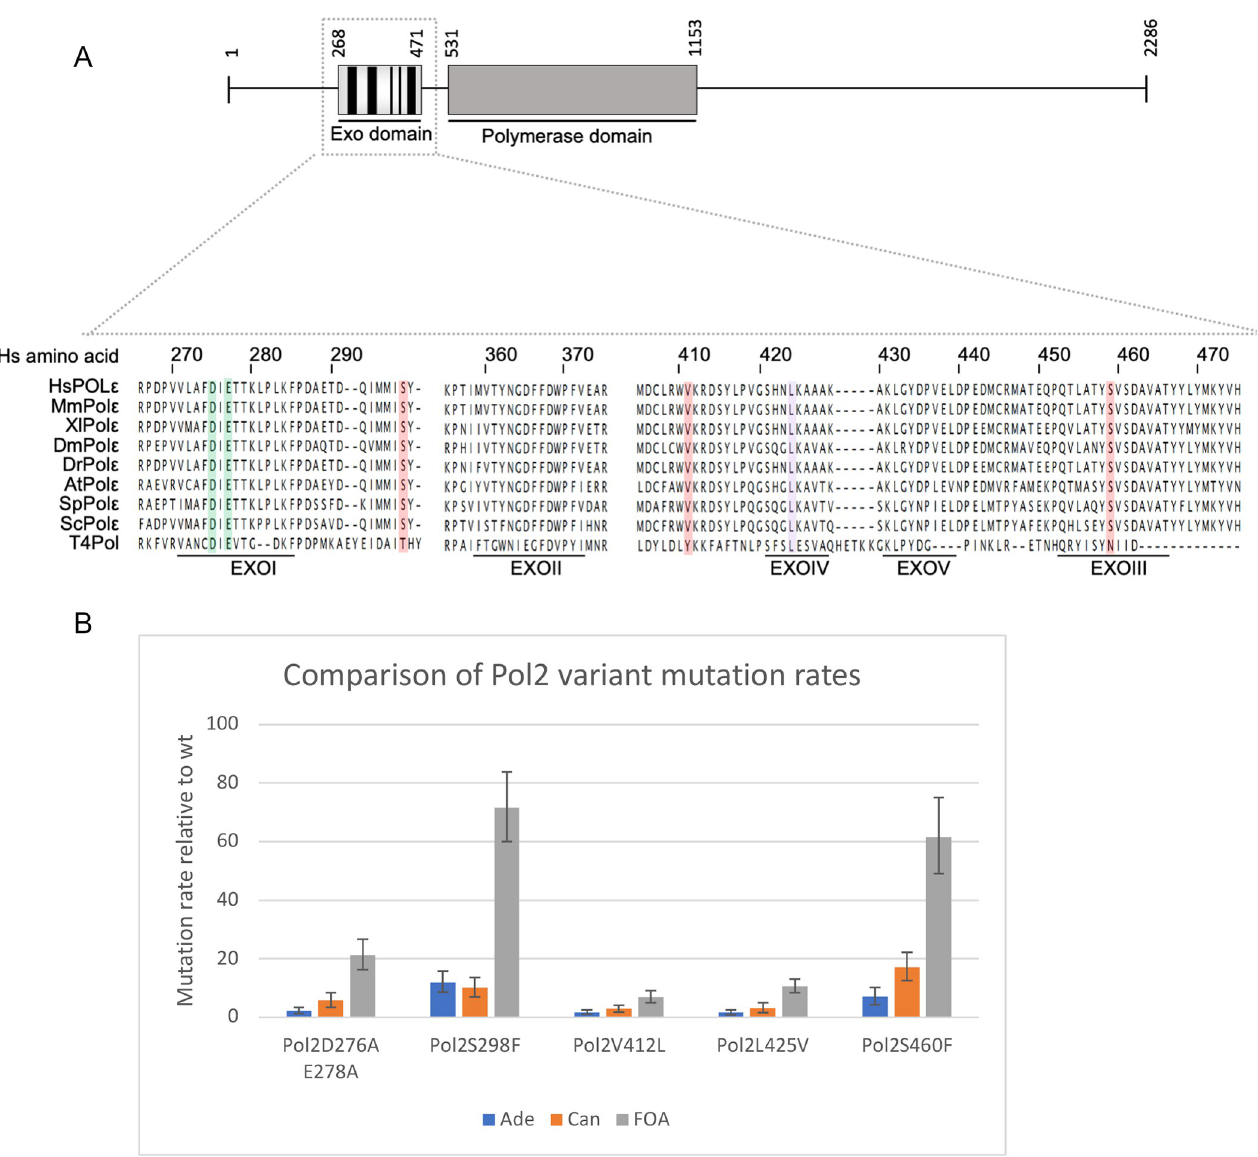
Fig 1. Mutation rates of DNA polymerase e variants. (A) DNA polymerase e variants used in this study showing alignment of exonuclease domain. Top panel shows a schematic representation of the human catalytic subunit of Pol ε . The 2286 amino acid long subunit contains the two catalytic activities of Pol ε : 3’- 5’exonuclease and 5’-3’ polymerase activity represented by the exo domain and polymerase domain, respectively. The exonuclease domain possesses five highly conserved domains called Exo motifs (I-V), highlighted in black. Lower panel shows an amino acid alignment of Pol ε and T4 polymerase sequences using T-Coffee [19] (default parameters; no matrix). Somatic and germline/somatic exonuclease domain mutations are highlighted in red, and violet, respectively, while the two catalytic sites are highlighted in green. Further details of the human clinical variants are shown in Table 1. Hs: human; Mm: mouse; Xl: Xenopus laevis ; Dm: Drosophilia ; Dr: Danio rerio ; At: Arabidopsis thalinana ; Sp: Schizosaccharomyces pombe ; Sc: Saccharomyces cerevisiae ; T4Pol: T4 DNA polymerase. (B) Mutation rates determined by fluctuation analysis of five DNA polymerase variants modelled in S . pombe , using ade6-485 reversion, resistance to canavanine or resistance to FOA. Y axis values represent: mutation rate of mutant/mutation rate of wt. Error bars show the range of three independent experiments. Correlation coefficients to the canavanine resistance data are 0.67 (Ade + reversion) and 0.86 (FOA resistance). Absolute mutation rates are given in S3